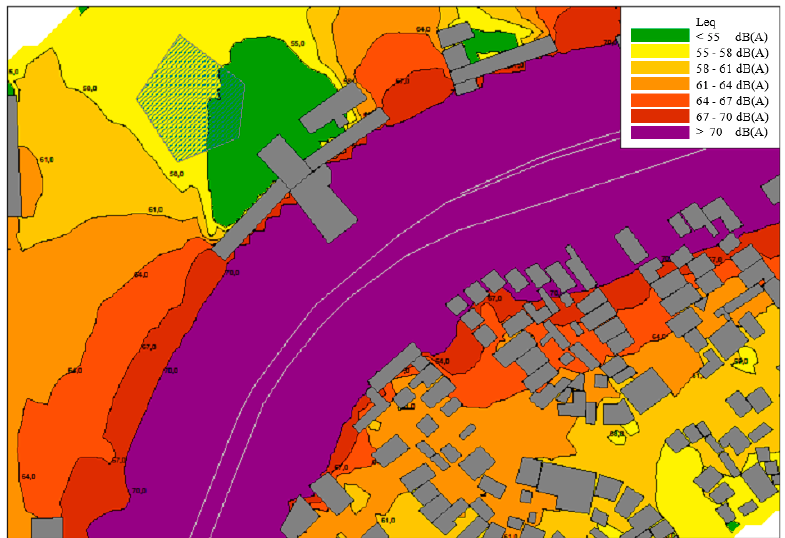
Figure 6. Noise map of the current situation—without a noise barrier—of sound propagation in front of the educational establishment, i.e., Medianeira School.